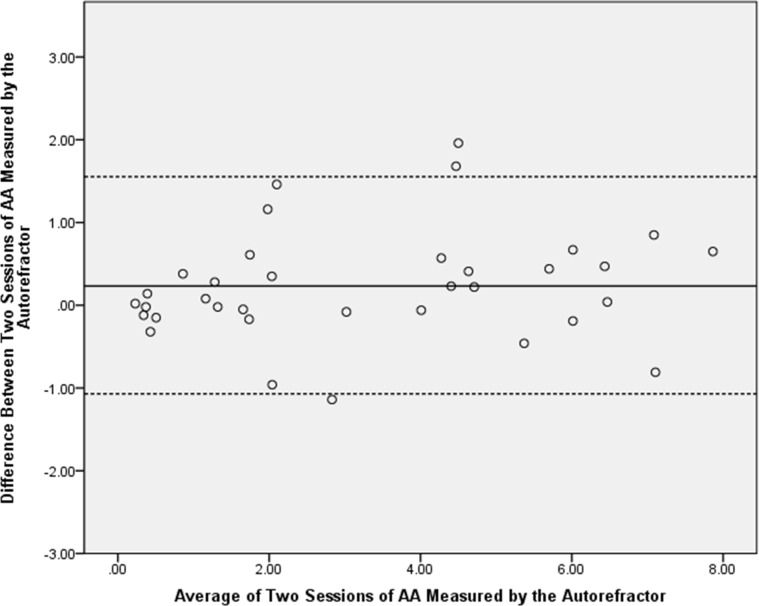
The Bland-Altman plots of repeatability for accommodative amplitude (AA) measurement.Repeatability of AA measured by the autorefractor. Mean difference, 0.23 D; 95% confidence limit, -1.07 to +1.53 D.